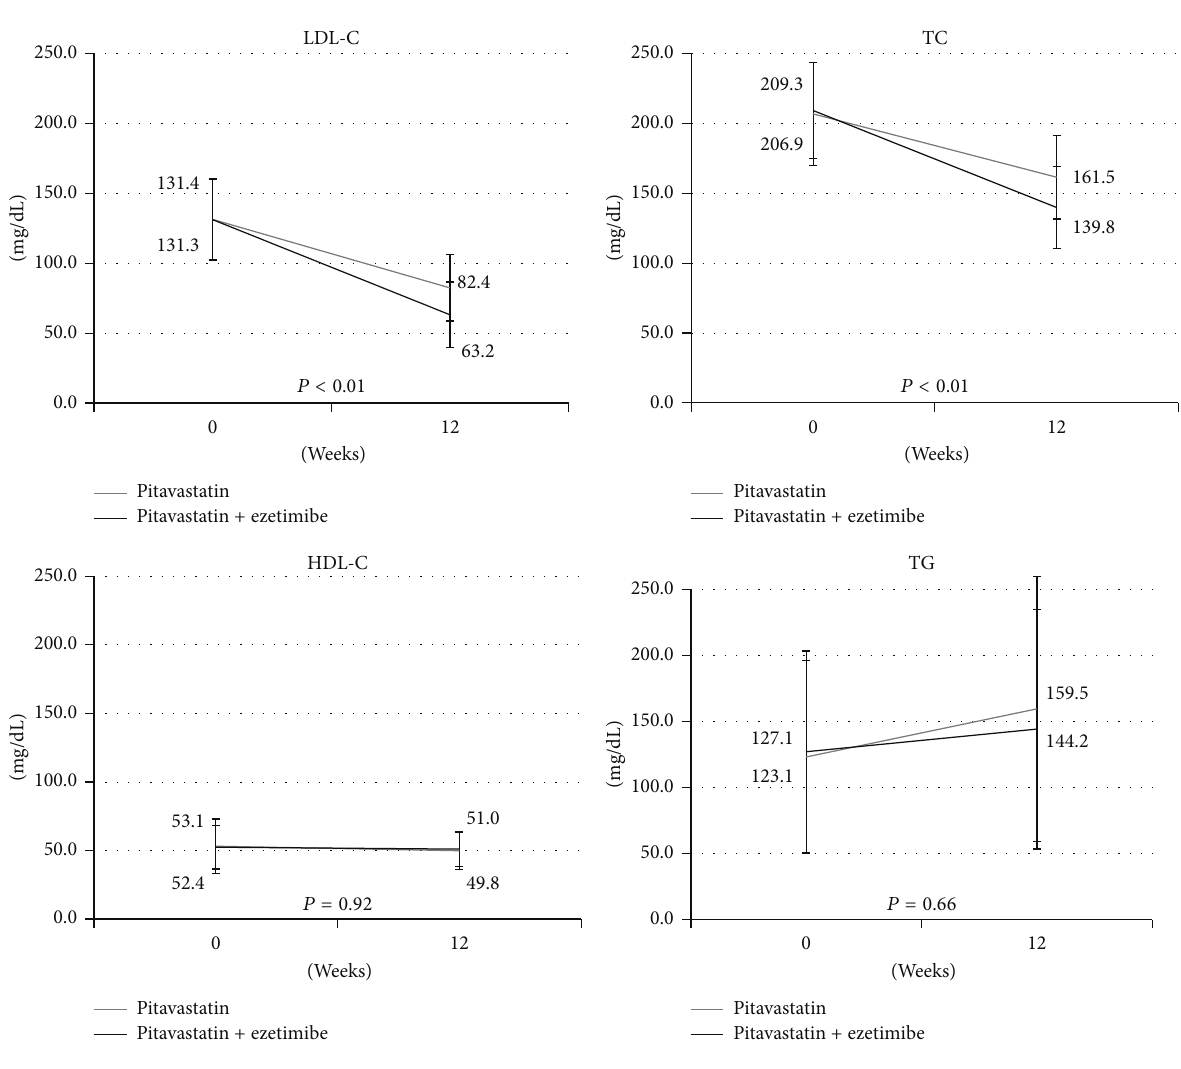
Figure 1: After 12 weeks of treatment, the serum levels of LDL-C and TC show a significant decrease in the pitavastatin + ezetimibe group compared to the pitavastatin group. In terms of the serum levels of HDL-C and TG, there are no significant changes in each